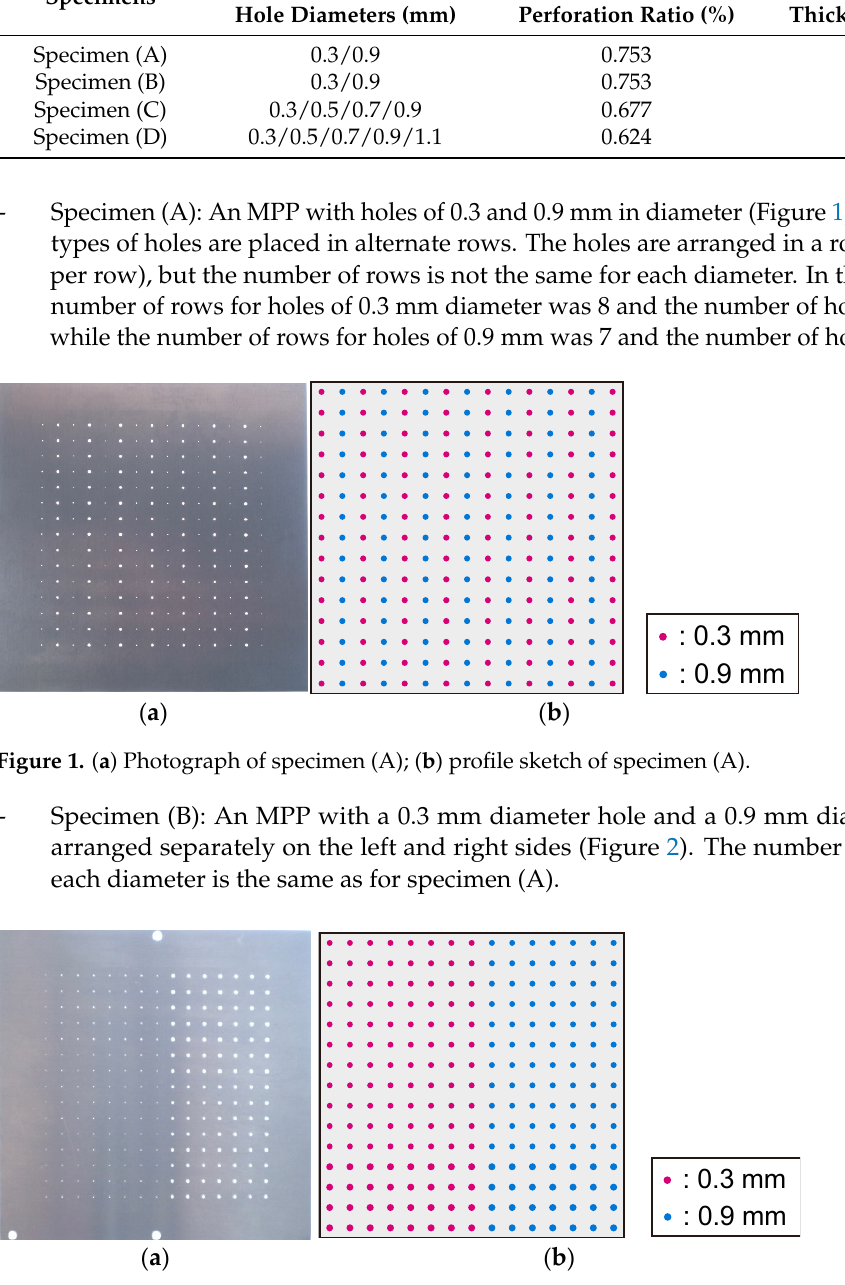
Figure 2. ( a ) Photograph of specimen (B); ( b ) profile sketch of specimen (B).